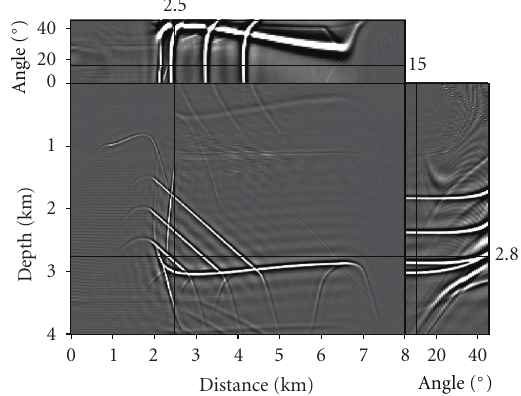
Figure 5: Migrated section after an isotropic migration with velocity of 2km/s of the TTI syntheticdata in Figure 4. The angle gathers obtained using an isotropic mapping at 2.5km location are displayed on the right, and the top section shows a depth slice as a function of angle gather at depth